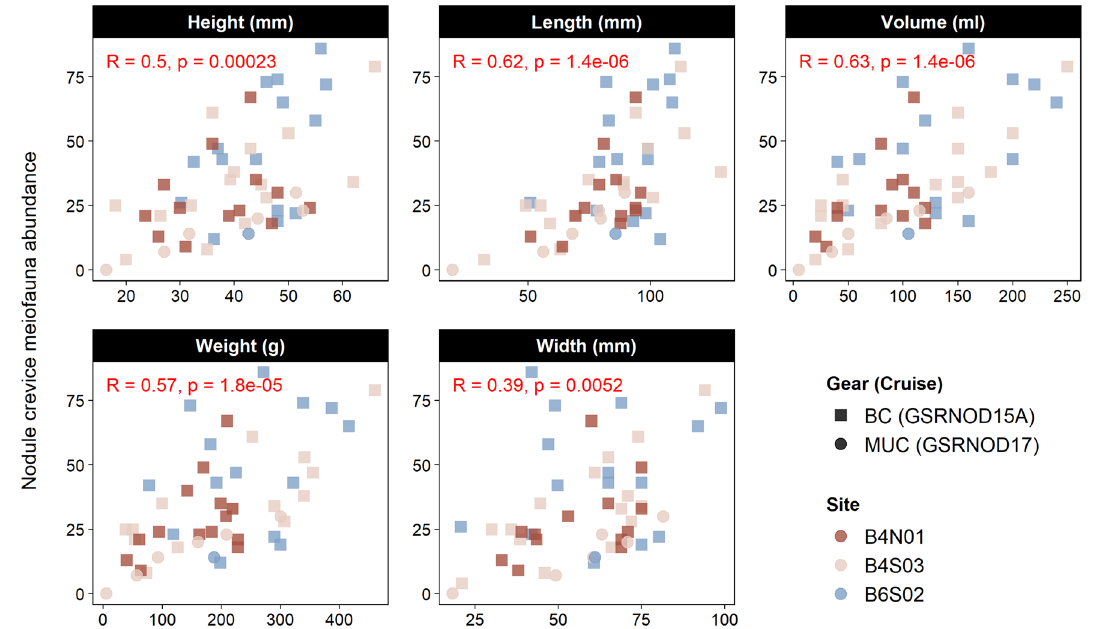
Figure 5. Nodule crevice meiofaunal abundance in function of physical nodule characteristics. Colors represent sites, and shapes denote sampling gear ( BC boxcorer, MUC multiple corer) and expedition. The Spearman rank correlation coefficient (R) and the associated P-value are given in red for each physical nodule